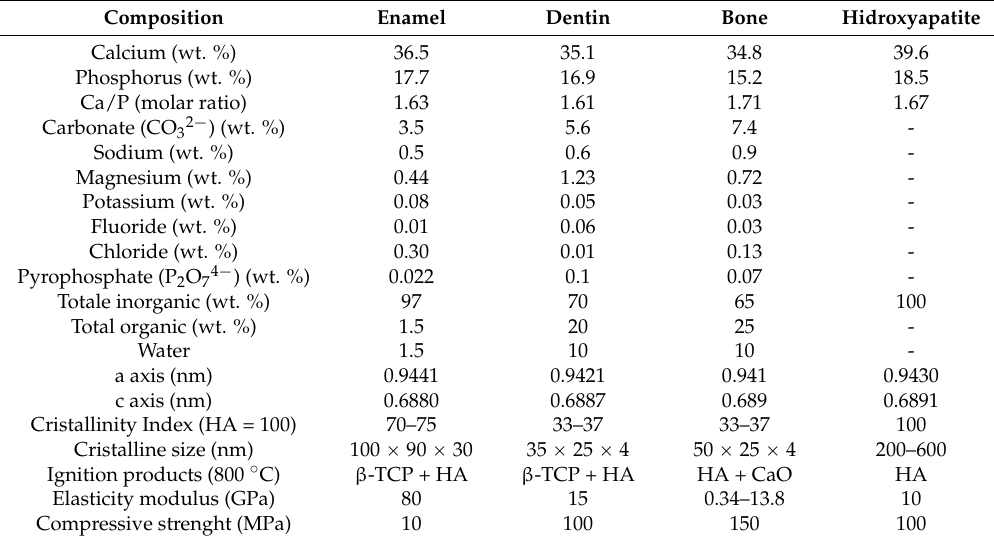
Table 1. Comparative compositions and structural parameters of inorganic phases of enamel, dentin, bone, and